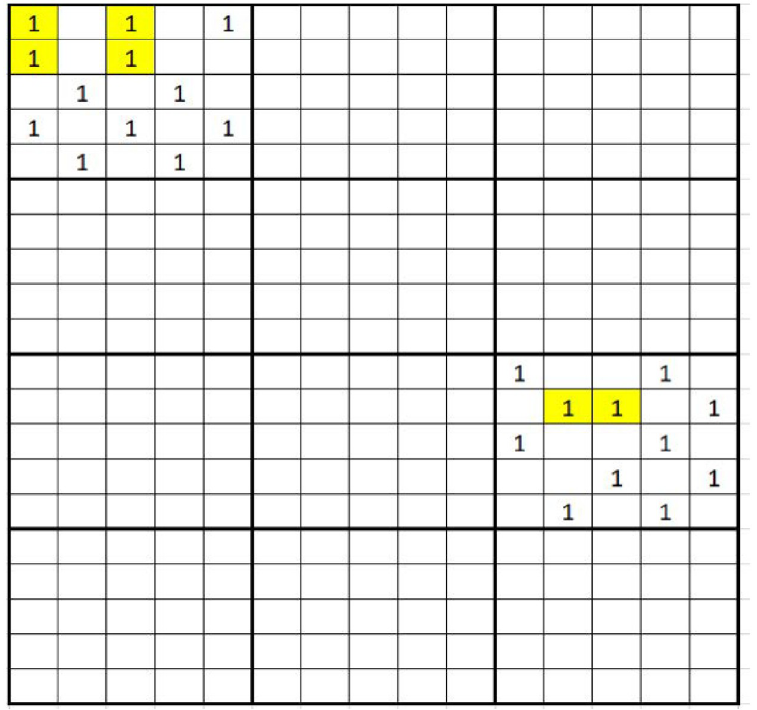
Fig 4. A population of 300 quadrats is partitioned into 12 PSUs of size 25. The variable of interest is binary. The value of those empty quadrats are 0. The value of each quadrat indicates the presence, 1, or the absence, 0, of a species. Two-stage adaptive cluster sampling is carried out and the neighborhood of a quadrat is the north, south, east and west quadrats. The highlighted quadrats are networks of size greater than one.